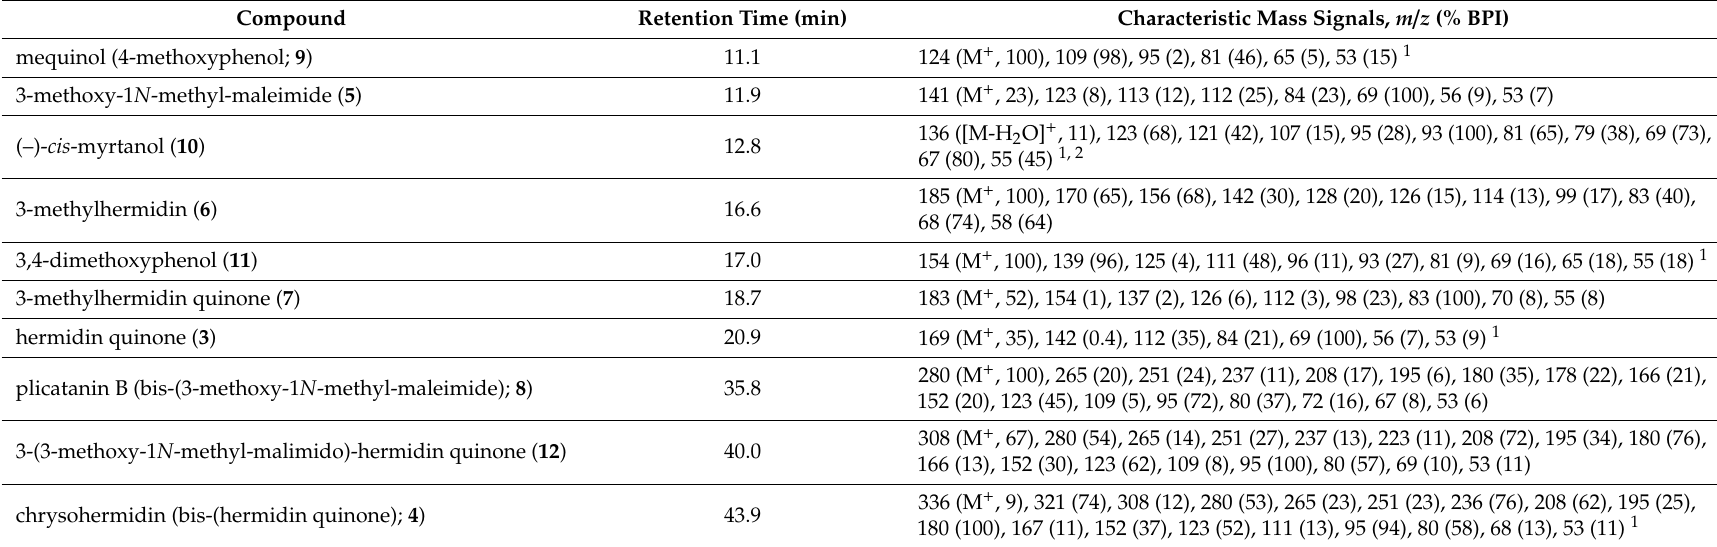
Table 2. Gas chromatography-mass spectrometry (GC-MS) data of compounds identified in unfermented and fermented root extracts of M.